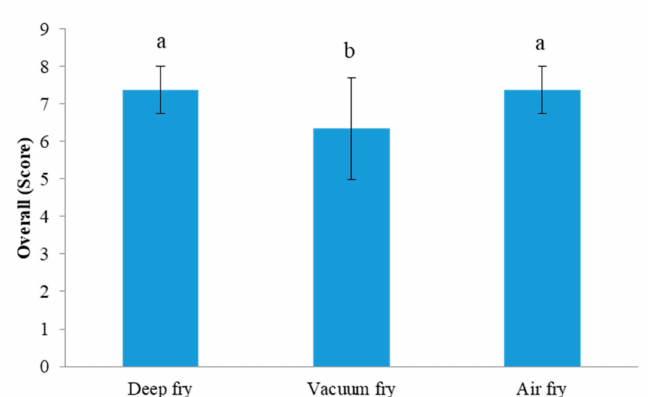
Figure 6. Sensory analysis of chub mackerel ( Scomber japonicus ) in different frying methods. Data are presented as mean ± SD. Different superscript letters (a,b) show significantly different values according to Duncan’s test ( p <